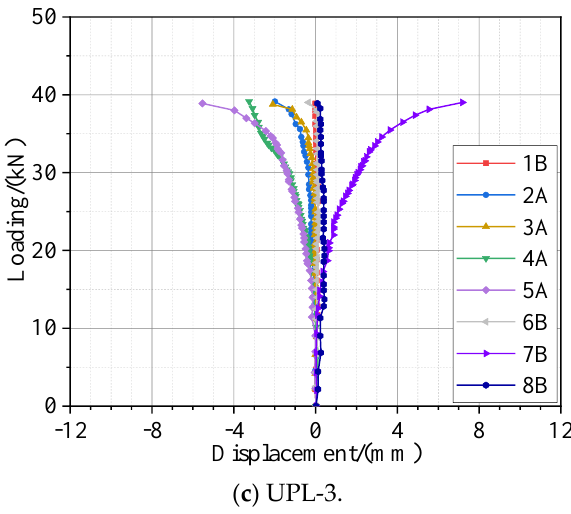
Figure 16. Loading−displacement curves of specimens in group 1. Loading-displacement curves of specimens in group 2 are shown in Figure 17a–c. For specimen UPU-1, the maximum displacement is from displacement transducer ‘5A’, while for specimens UPU-2 and UPU-3, the maximum displacement is also from displacement transducer ‘7B’ (refer to Figure 11). The maximum displacement of three specimens is in between 3.8 and 11.2 mm.